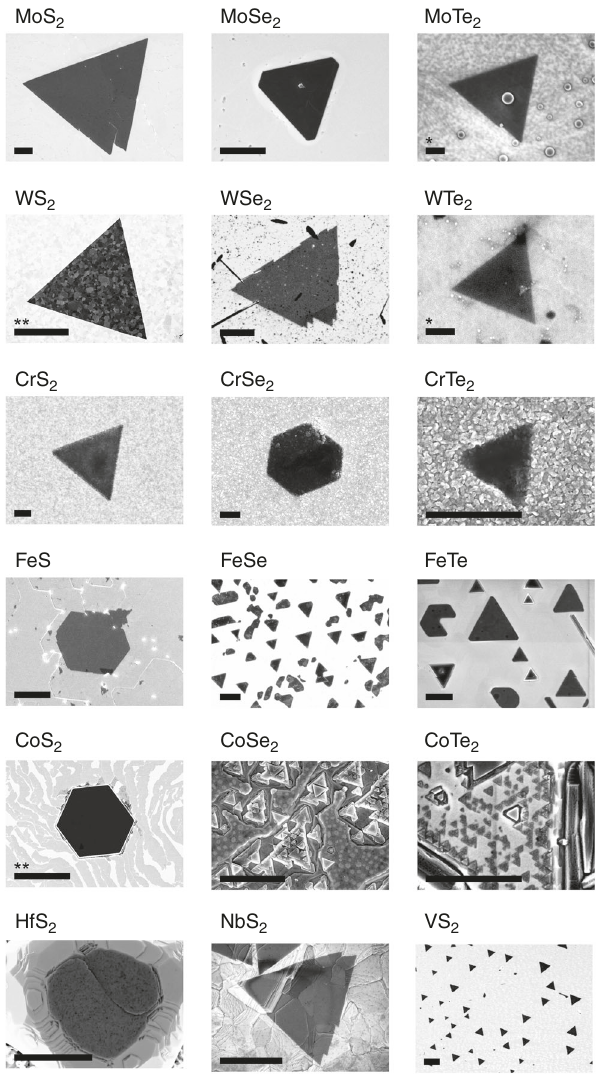
Fig. 5 Library of layered transition metal chalcogenides. SEM images of the various transition metal chalcogenides grown by the present method. All presented materials are grown under identical process conditions, varying only M and X . Further characterisation for the materials is presented in Supplementary Figs. 2 – 18. Scale bars are 1 µ m except where